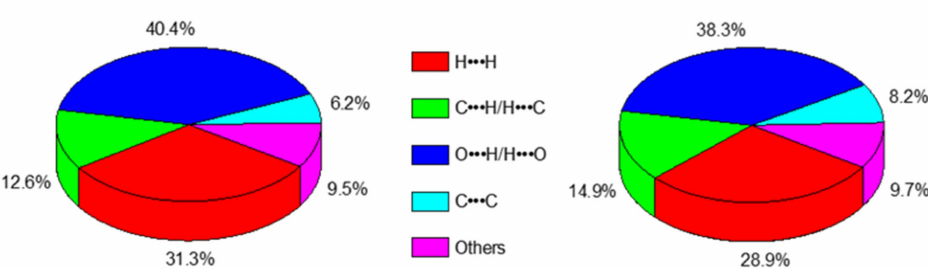
Figure 6. Fingerprint plots of compound 1 and 2 .